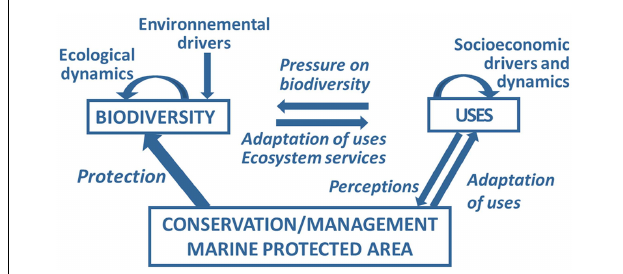
FIGURE 1 | Conceptual model used for Projects 2 and 3. The model depicts the relationships between biodiversity, uses, and management responses in the MPA. It was derived from the DPSIR (Driving forces-Pressure-State-Impact-Response) framework (Organisation for Economic Co-operation and Development [OECD], 1993), developed for indicator definition and widely used in environmental assessments (Beliaeff and Pelletier, 2011).